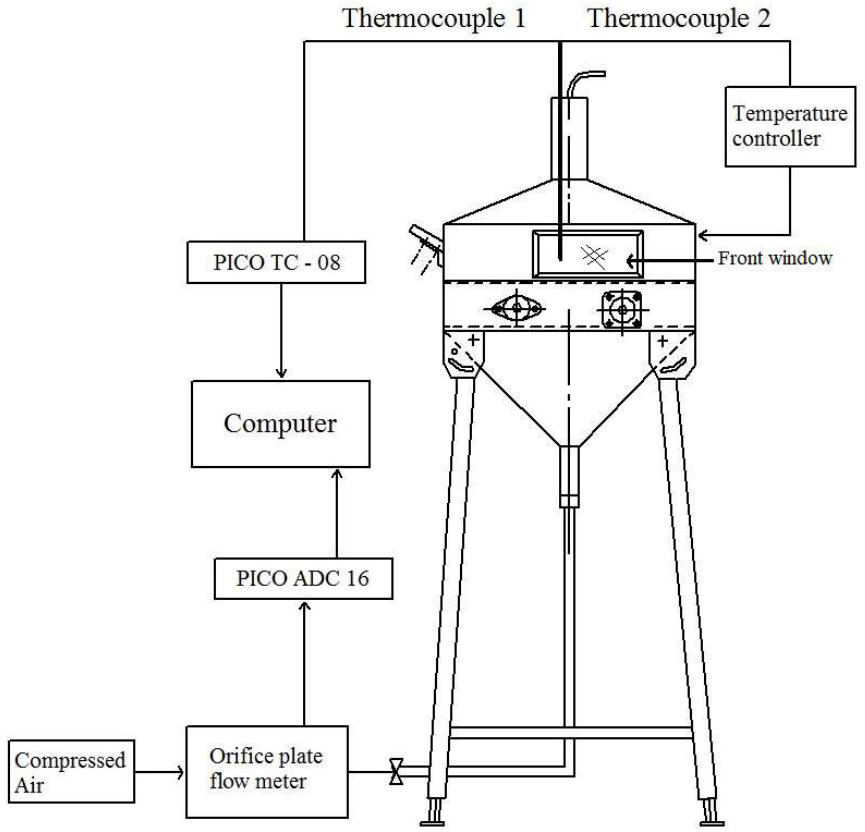
Figure 3. Schematic representation of the experimental setup.